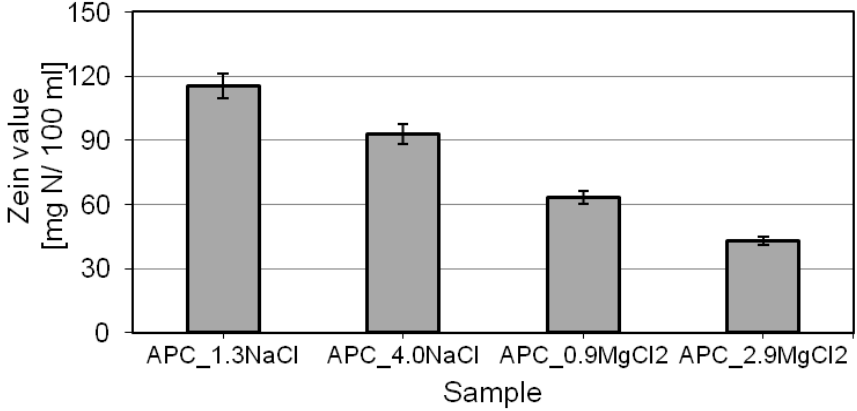
Figure 7. Zein values of APCs.